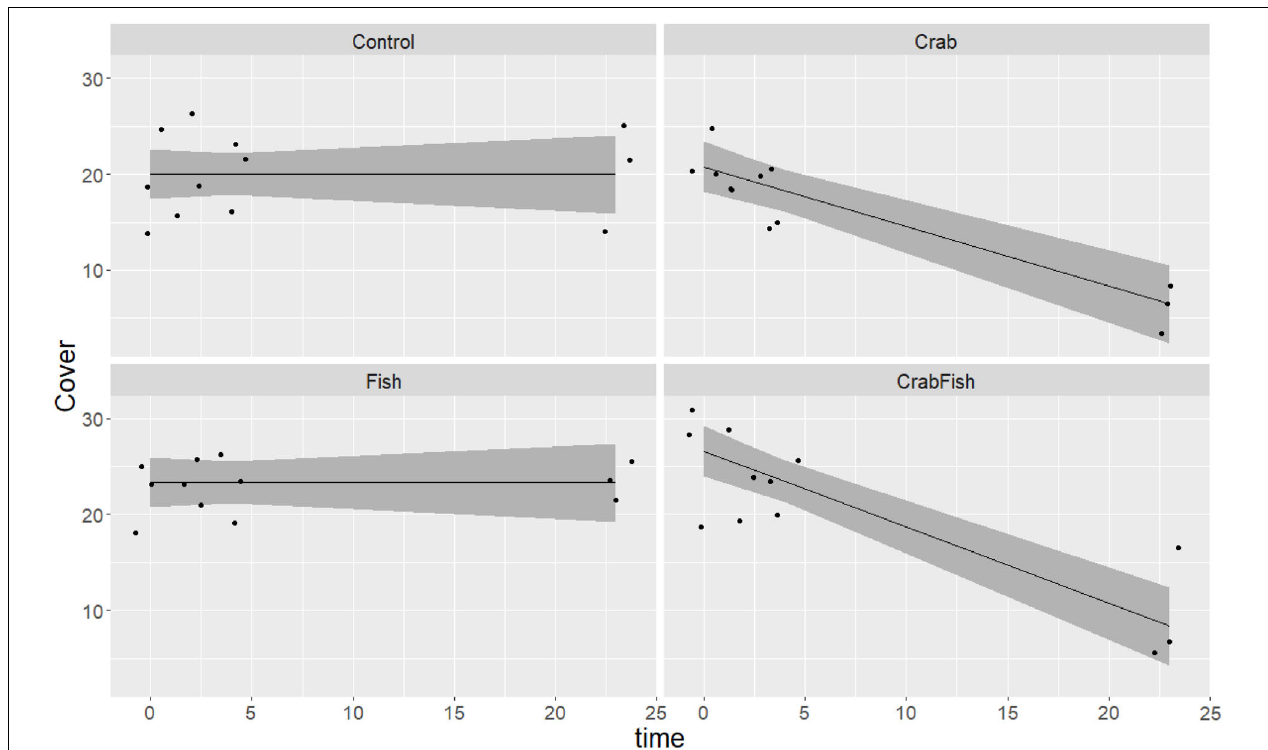
FIGURE 3 | Predicted and observed development of B. improvisus cover over time in a 24 h experiment in October 2019, given four different treatments (Control: no predators added, Crab: only crabs added as predator, Fish: only fish added as predator, CrabFish: i.e., both crabs and fish added as predator species to the mesocosms). The shaded area shows the 95% confidence levels of the predicted GAM values (i.e., cover as a function of treatment + time × treatment) and the points represent the observed cover at different